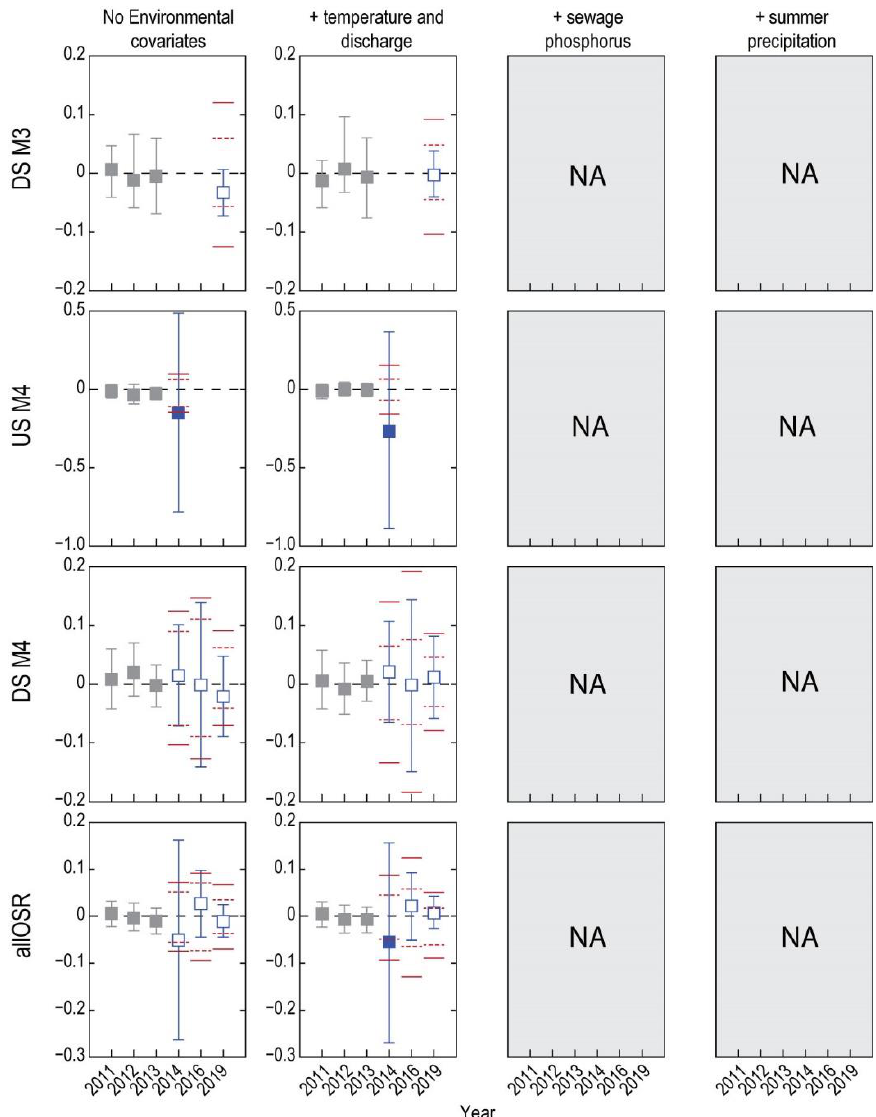
Figure 5. Median residual gonad weight (GW) of male white sucker (±log10; g) from site-specific regressions done without environmental covariates, with T and D, with T, D, and P, and either T, D, P, and Pr, or T, D, and Pr; “NA” indicates a non-applicable analysis; upper and lower dashed horizontal red lines denote 97.5 and 2.5 percentiles, respectively; upper and lower solid horizontal dashed lines denote outer tolerance limits for the 97.5 and 2.5 percentiles, respectively; error bars in observed test and reference data show 95% confidence intervals; solid symbols suggest a potentially relevant difference; open symbols show potentially irrelevant differences; solid grey symbols denote baseline years (2011–2013) used to derive thresholds used for test years (2014, 2016, 2019).